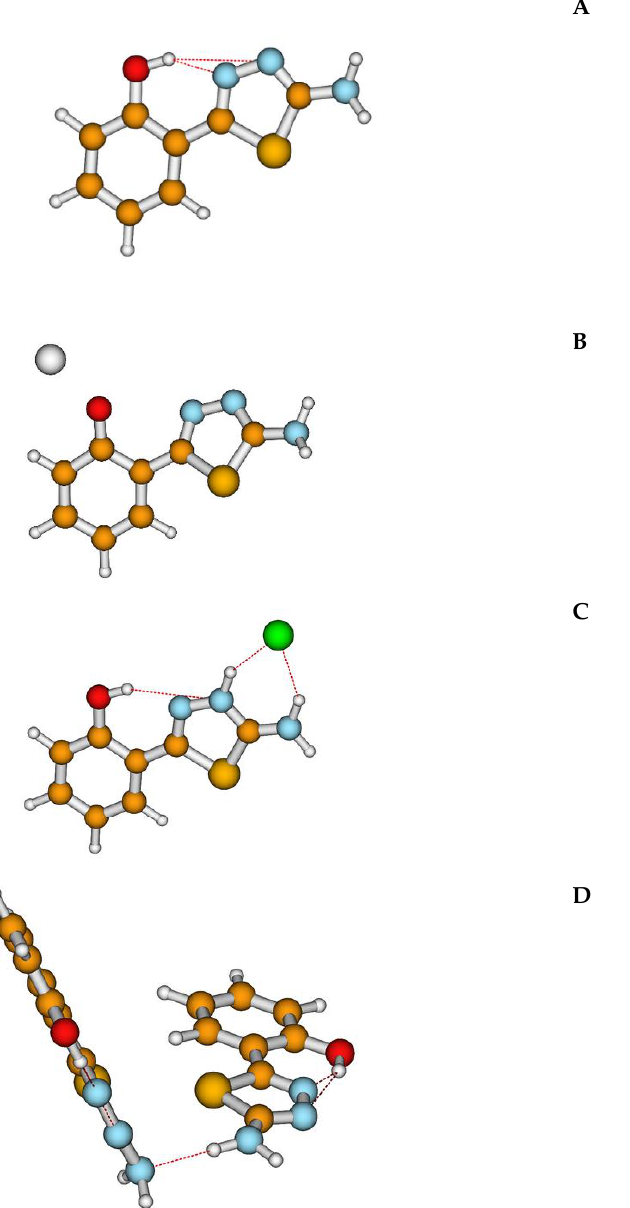
Figure 8. Ground state structures of TS − ( A ), TSH ( B ), TSH 2 + ( C ) and (TSH) 2 ( D ) as optimized using B3LYP / aug-cc-pVDZ and polarizable continuum model (PCM) with water as the solvent. Table 3. Predictions for low-lying excited states of various forms of the TS molecule in water. Energetics given in nm scale, dimensionless oscillatory strengths for the absorption process given in